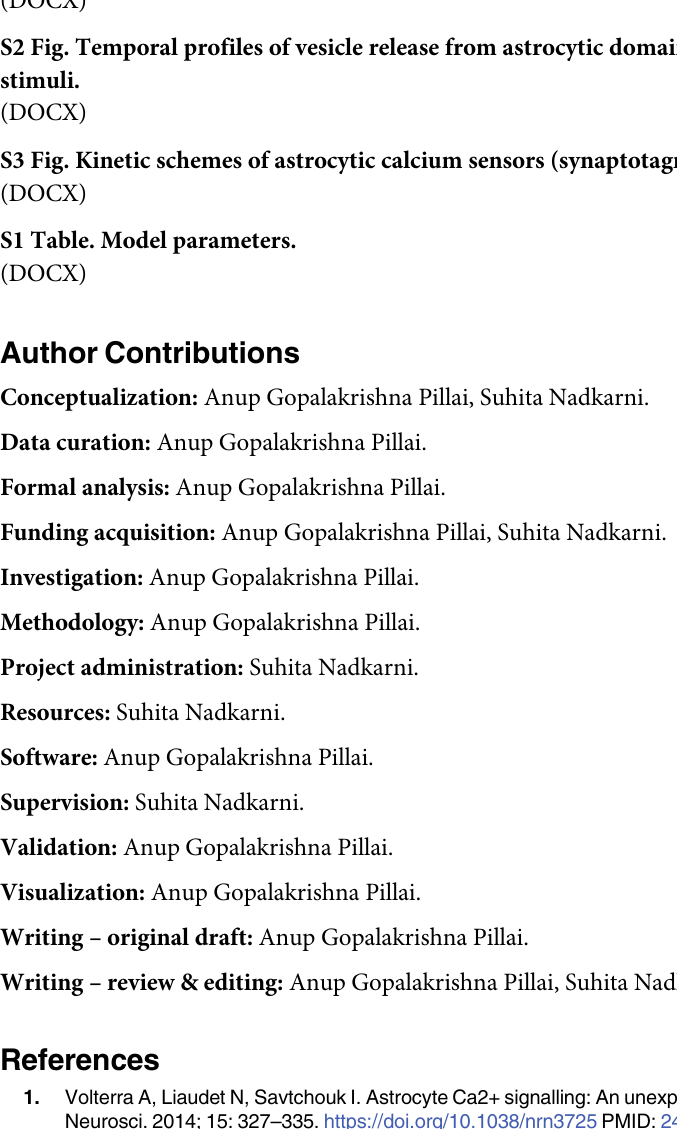
and Ca 2+ concentrations. 3